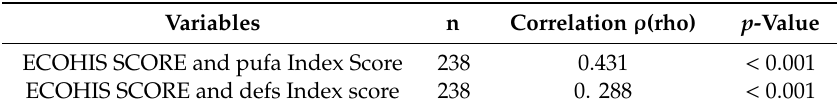
Table 6. Correlation between ECOHIS scores with pufa and defs scores. [Spearman’s correlation test ( ρ (rho), statistically significant at p <